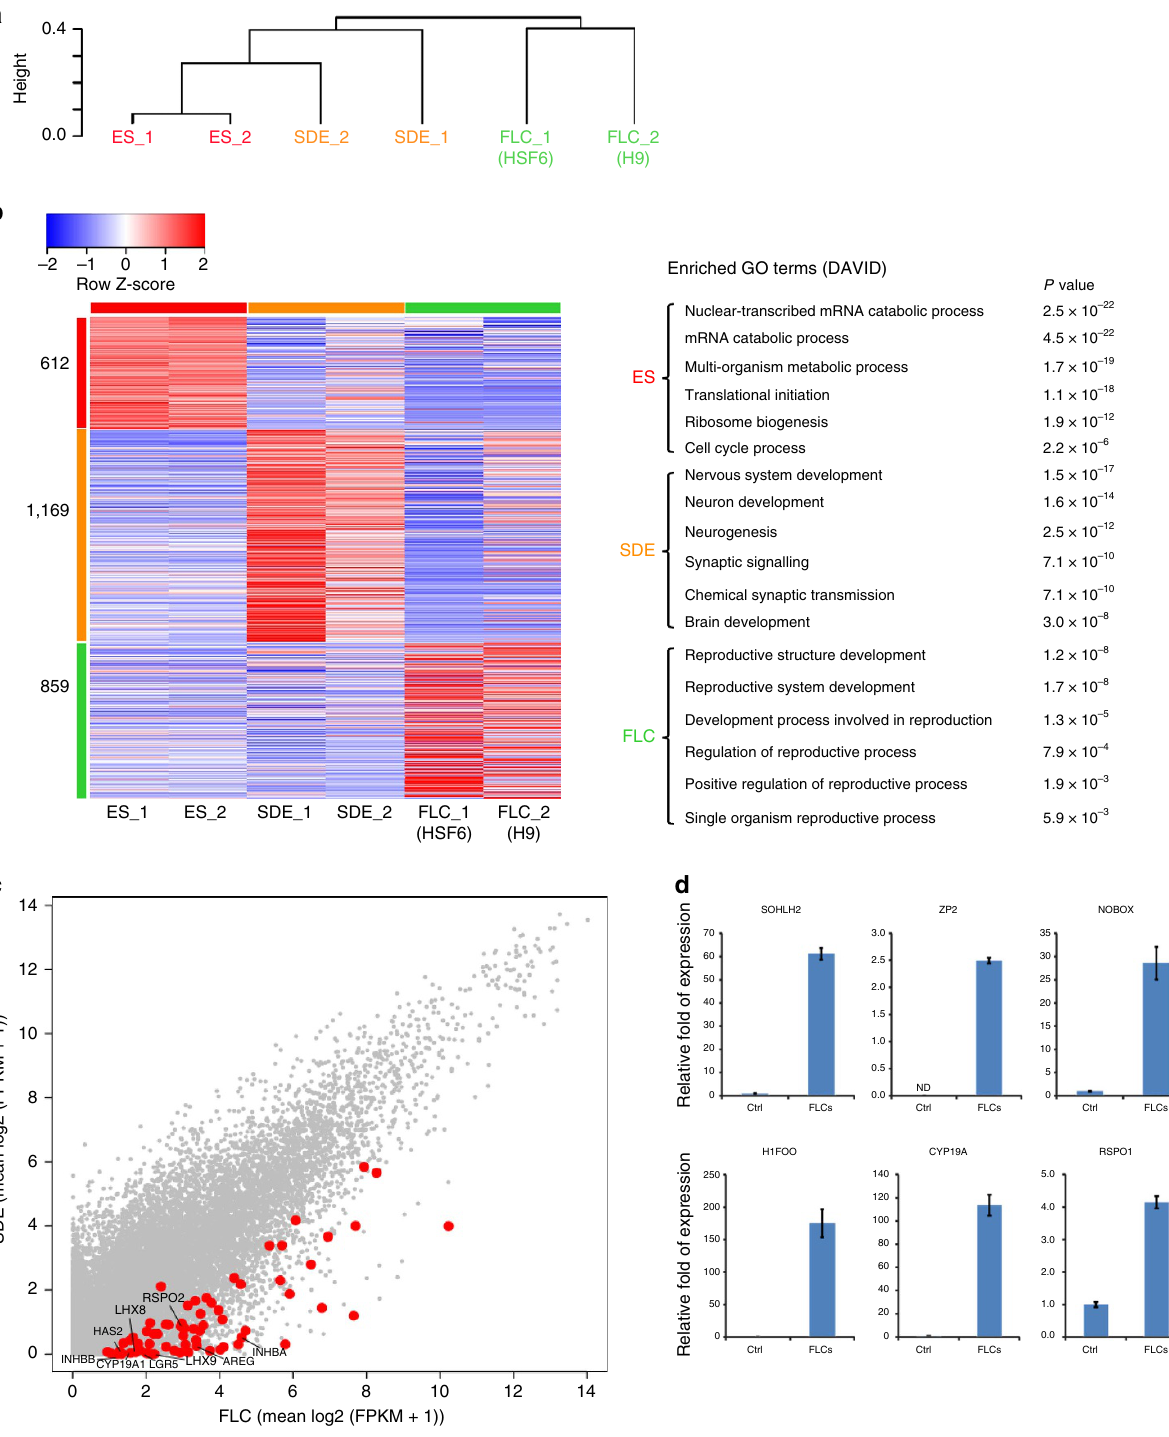
Figure 6 | Transcriptional profiles of FLCs by whole-genome RNA sequencing and qPCR. ( a ) Unsupervised hierarchical clustering of gene expression in hESC (ES), spontaneously differentiated hESCs (SDE) and FLCs (one sample from H9 and one from HSF6). Independent biological duplicates of each group were subjected to whole-genome RNA sequencing. ( b ) Heat map of gene expression of ES, SDE and FLC shows different expression of genes in these three groups. Left, heat map; right, gene ontology (GO) of 612, 1169 and 859 differentially expressed genes. ( c ) Scatter plot analysis of transcripts between SDE and FLC. Red dots show genes enriched in reproductive tissues (oocytes or granulosa cells) that are highly expressed in FLC. ( d ) mRNA expression of SOHLH2, ZP2, NOBOX, H1FOO, CYP19A and RSPO1 was evaluated by an independent experiment collecting 30 FLCs compared with the same number of cells from control cultures. n ¼ 3 (technical replicates of 30 independent FLCs collected and pooled together), error bar indicates SD, 4 3 independent